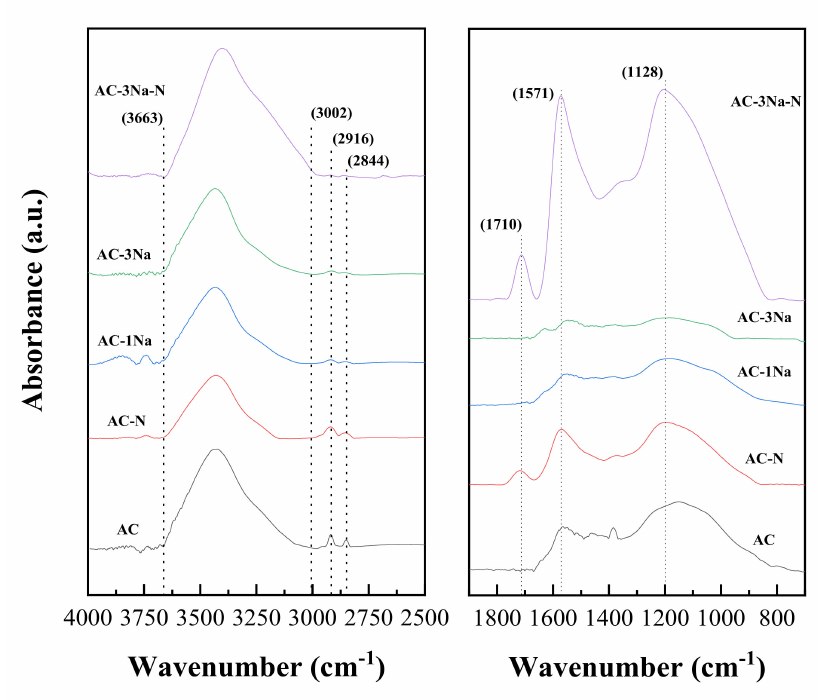
Figure 3. FT-IR spectra of AC